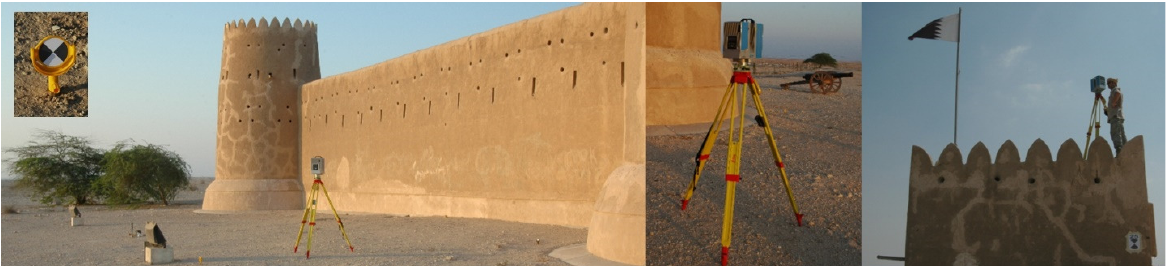
Figure 2: Terrestrial laser scanner IMAGER 5006h in use at fort Al